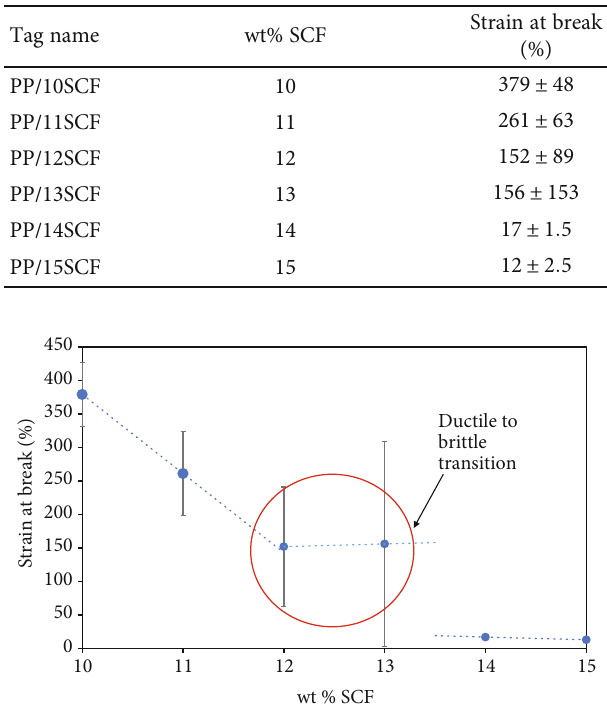
Figure 5: Strain at break of the PP/SCF composite with 10 – 15wt% of